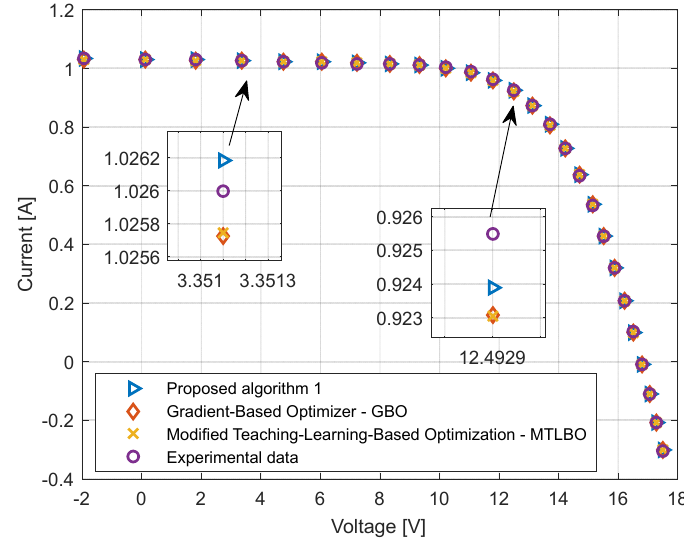
Figure 9. Current-voltage characteristics of the Photowatt-PWP201 module.